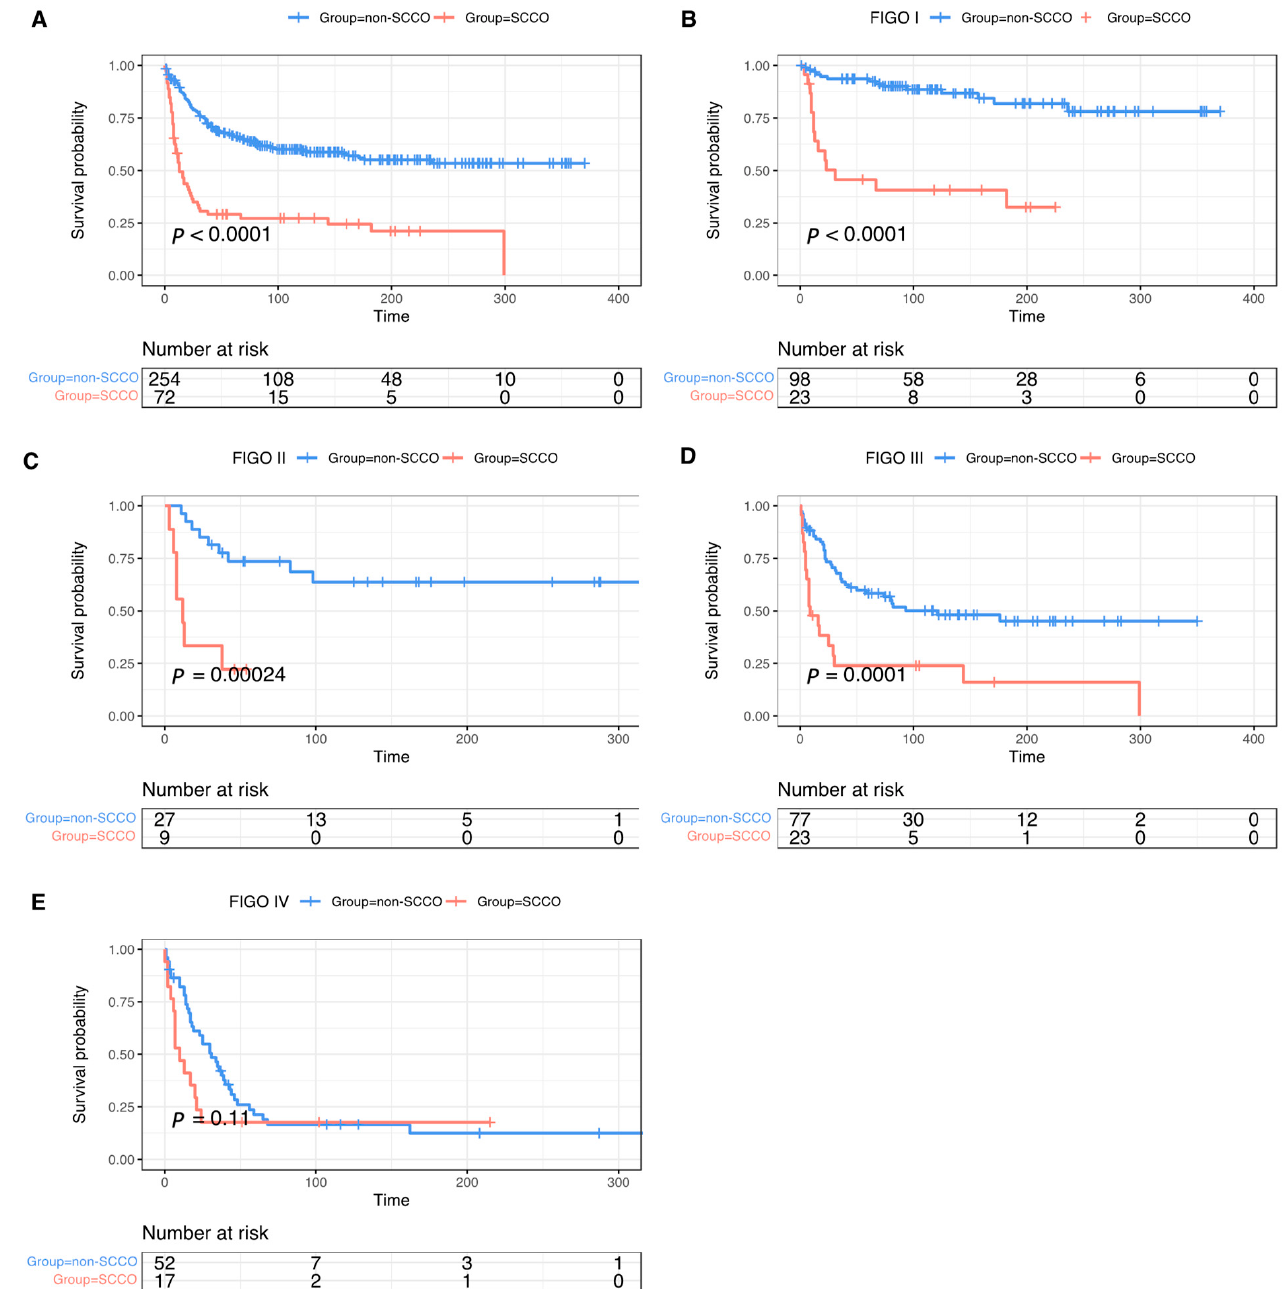
Figure 2. Survival curves of overall survival among patients with SCCO and non-SCCO. All stages ( A ), stage I ( B ), stage II ( C ), stage III ( D ), and stage IV ( E ) in matched cohort.